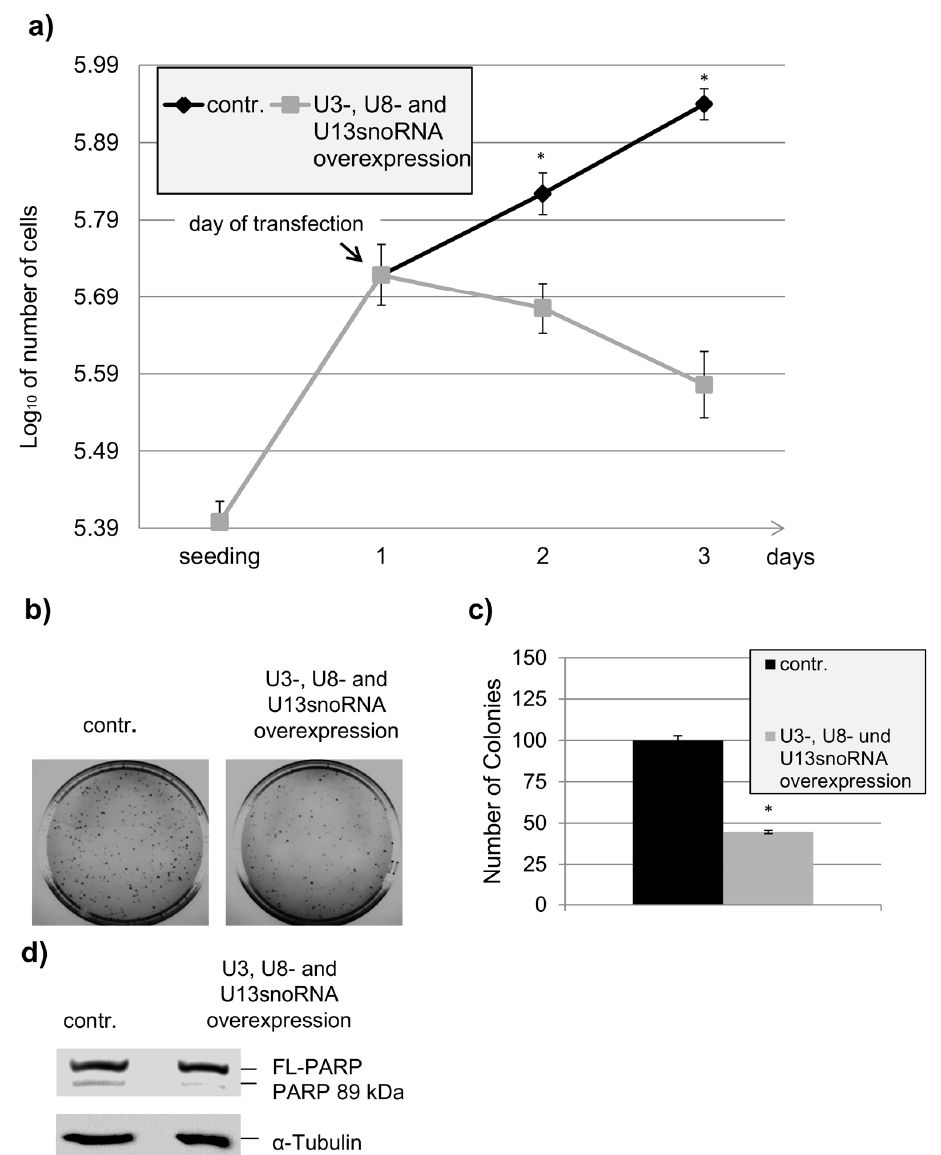
Figure 5. Inhibition of HeLa cell proliferation by external co-expression of U3-, U8-, and U13snoRNA. ( a ) Cell proliferation on the dependence of U3-, U8-, and U13snoRNA overexpression. Cells were transfected with a mixture of the U3-, U8-, and U13snoRNA expression plasmids (pcDNAU3, pcDNAU8, pcDNAU13), or the empty vector (pcDNA3.1( − )), and growth curves were established in a half logarithmic scale (mean ± SD; n = 3; * p value < 0.05); ( b ) An overview of the outcome of a colony forming assay performed with control cells and HeLa cells overproducing U3-, U8-, and U13snoRNA; ( c ) Quantitative analysis of the colony forming assay (mean ± SD; n = 3; * p value < 0.05). ( d ) Western blot analysis of poly(ADP-ribose) polymerase (FL-PARP) and its cleavage product (PARP 89kDa, known as an indicator of apoptotic cell death). α‐ Tubulin served as a loading control.